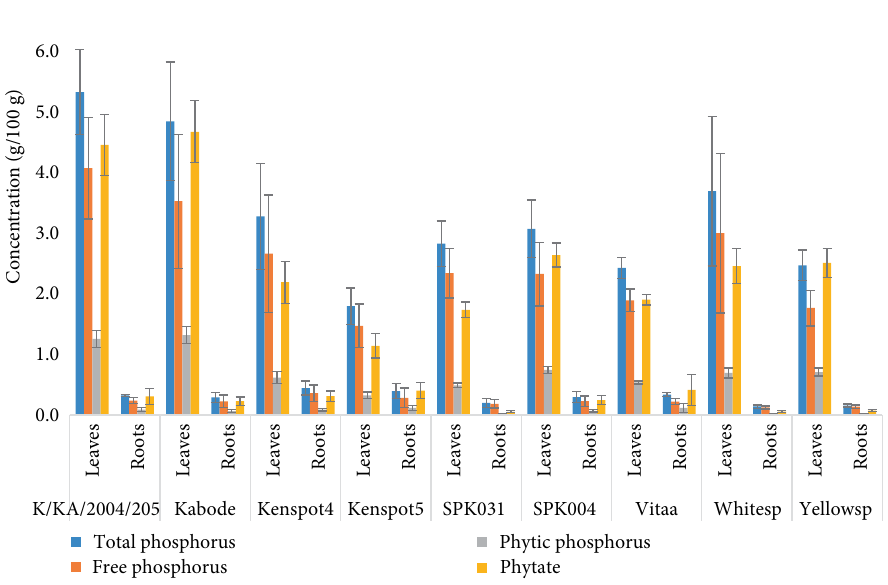
Figure 4: Variations in phosphorus and phytate contents in roots and leaves of nine Kenyan sweet potato varieties. The bars indicate standard error of the Table 4: Pearson correlation ( r ) between phytochemicals and anti- oxidant property.